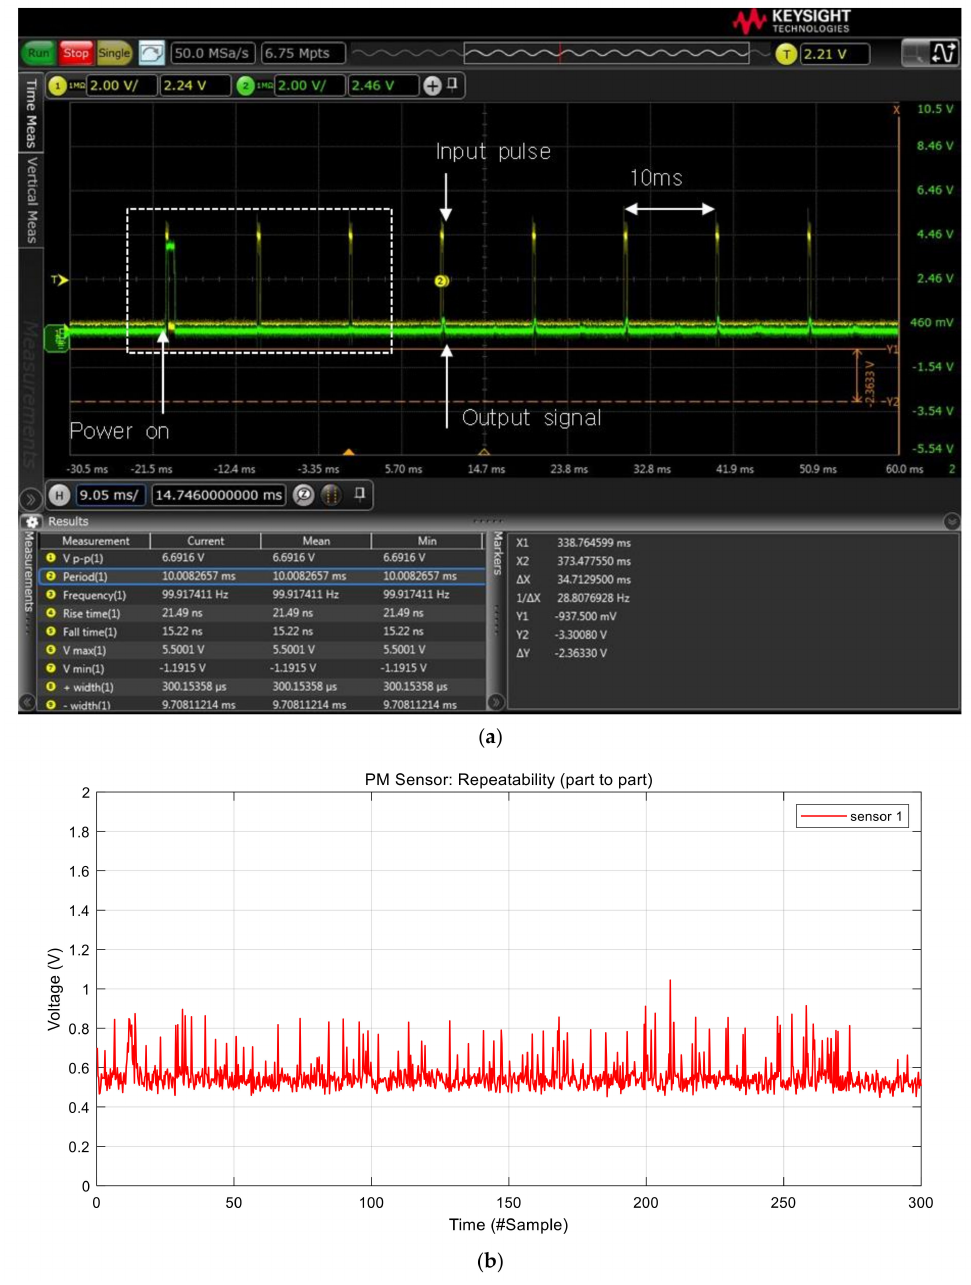
Figure 3. Output signal of the PM sensor: ( a ) oscilloscope capture and ( b ) the measured output data by the